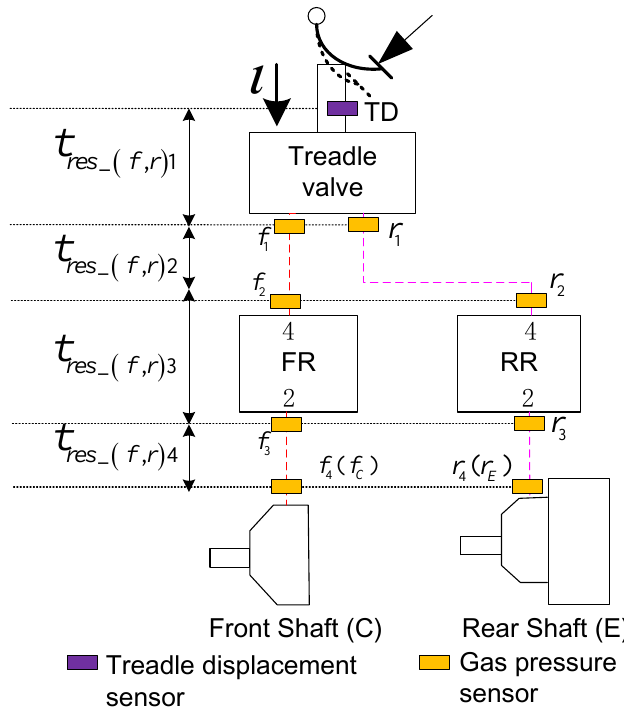
Figure 7. Arrangement of sensors. TD: treadle displacement sensor.